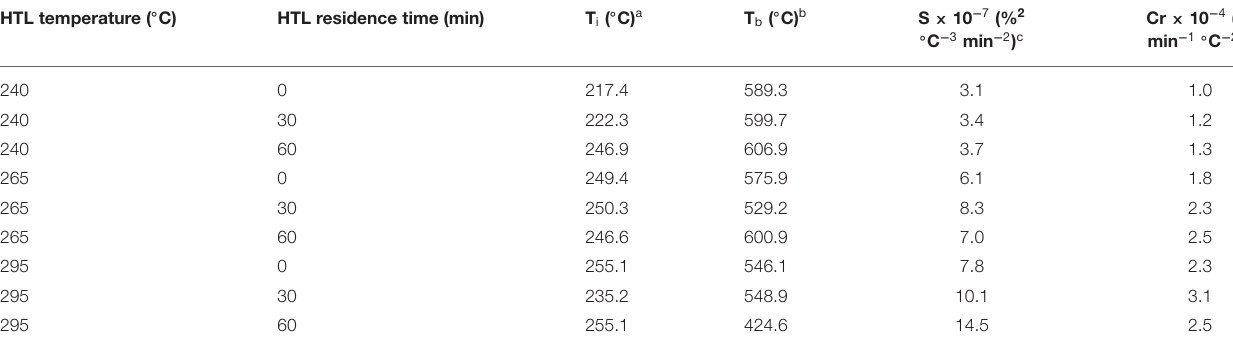
TABLE 2 | Combustion characteristics of bio-crude oils calculated from thermogravimetric data under an air atmosphere. HTL temperature ( ◦ C)